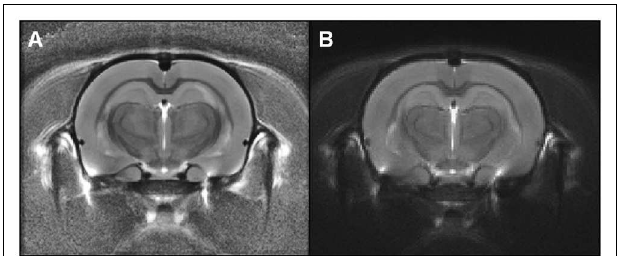
FIGURE 3 | Rat templates issued from Sammba-MRI (A) or SPM-based (B) registrations. These templates were calculated from anatomical images of 10 animals. Visual observation suggests similar quality of the two templates.